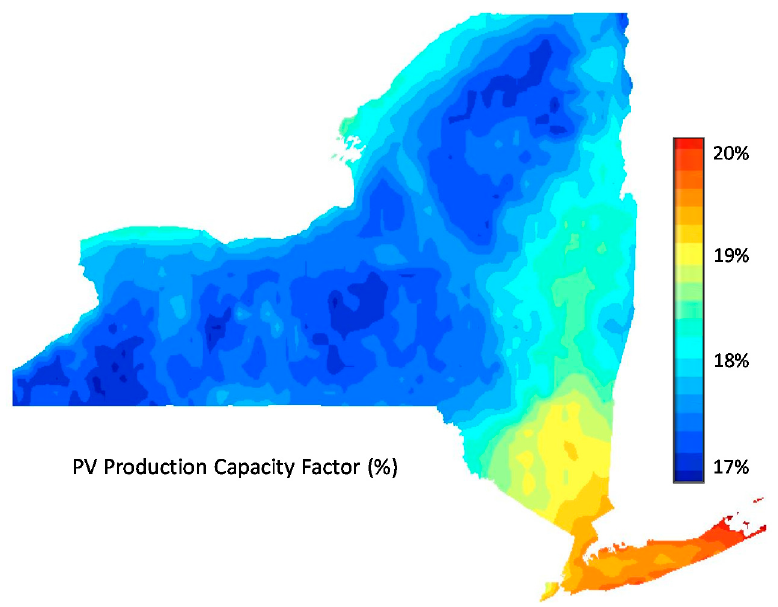
Figure 3. New York State solar resource for 2016—annual PV production capacity factor.